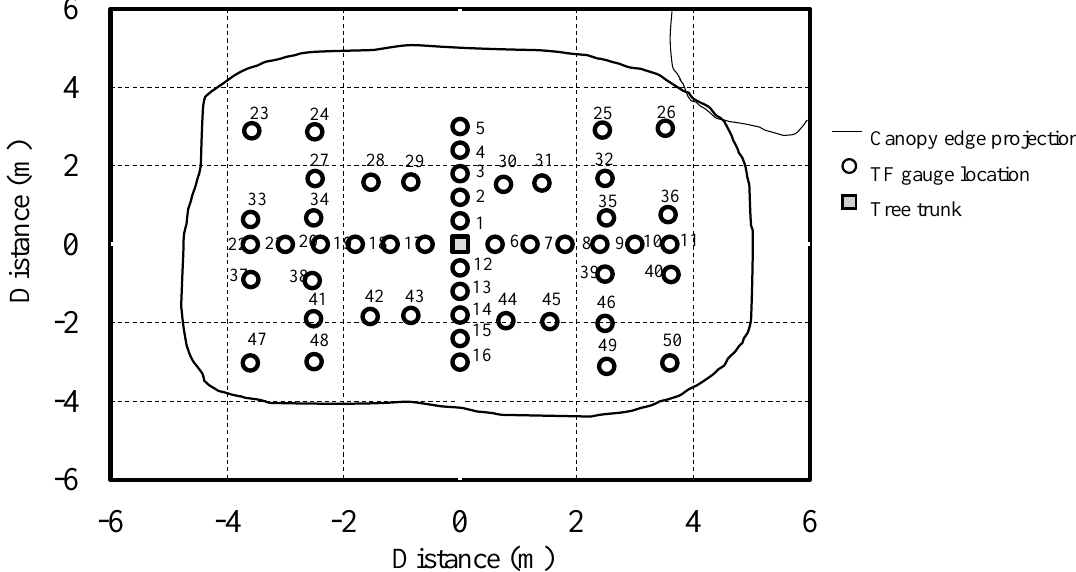
Figure 1. Location of the 50 throughfall gauges under the Quercus castaneifolia C.A.Mey. study tree .